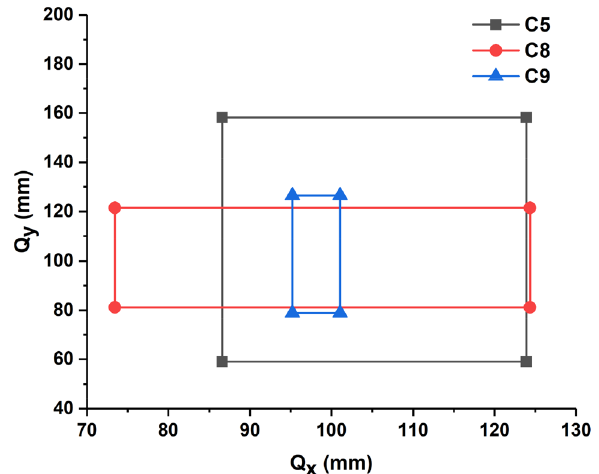
Fig. 19 Experimental workspace area of manipulators